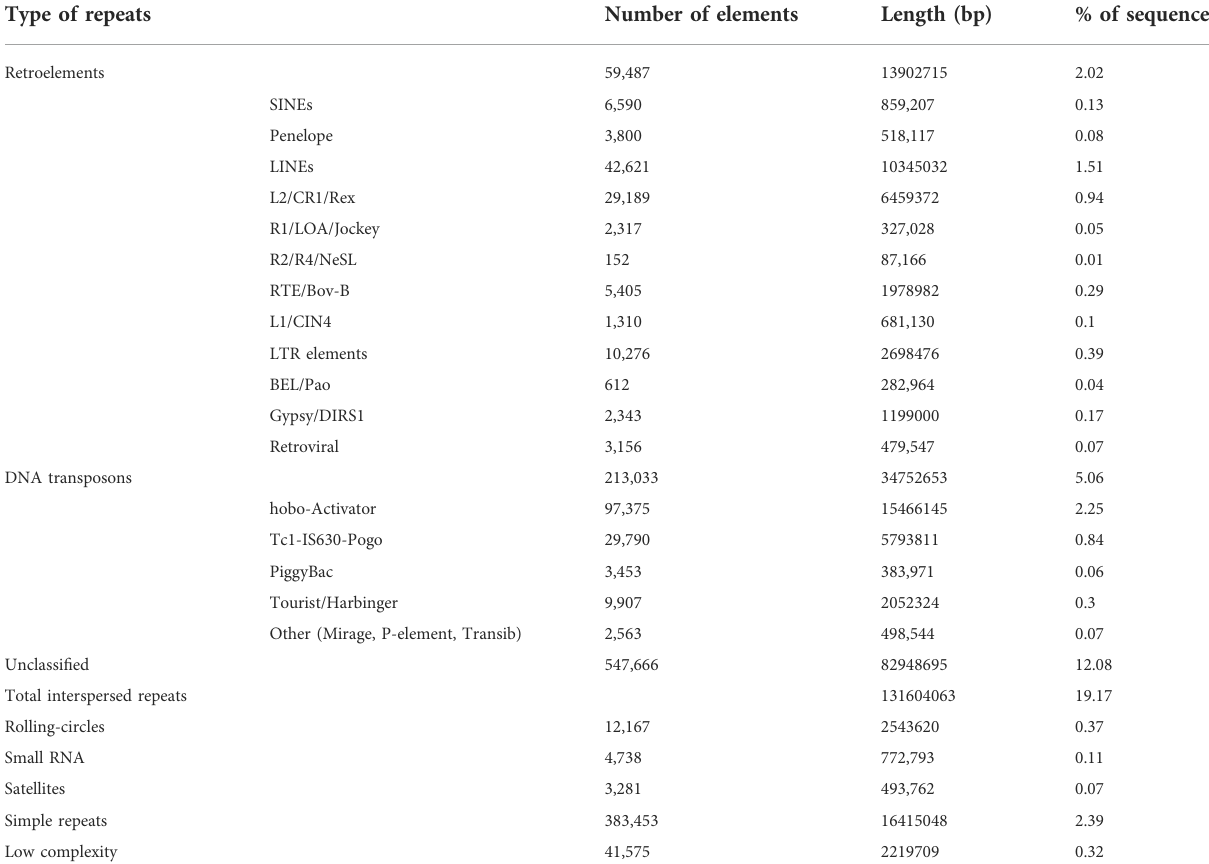
TABLE 2 Repeat annotation of the